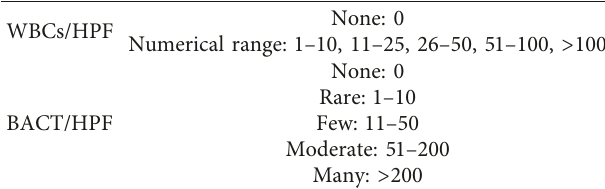
Table 1: Category of leukocyte and bacterial parameter